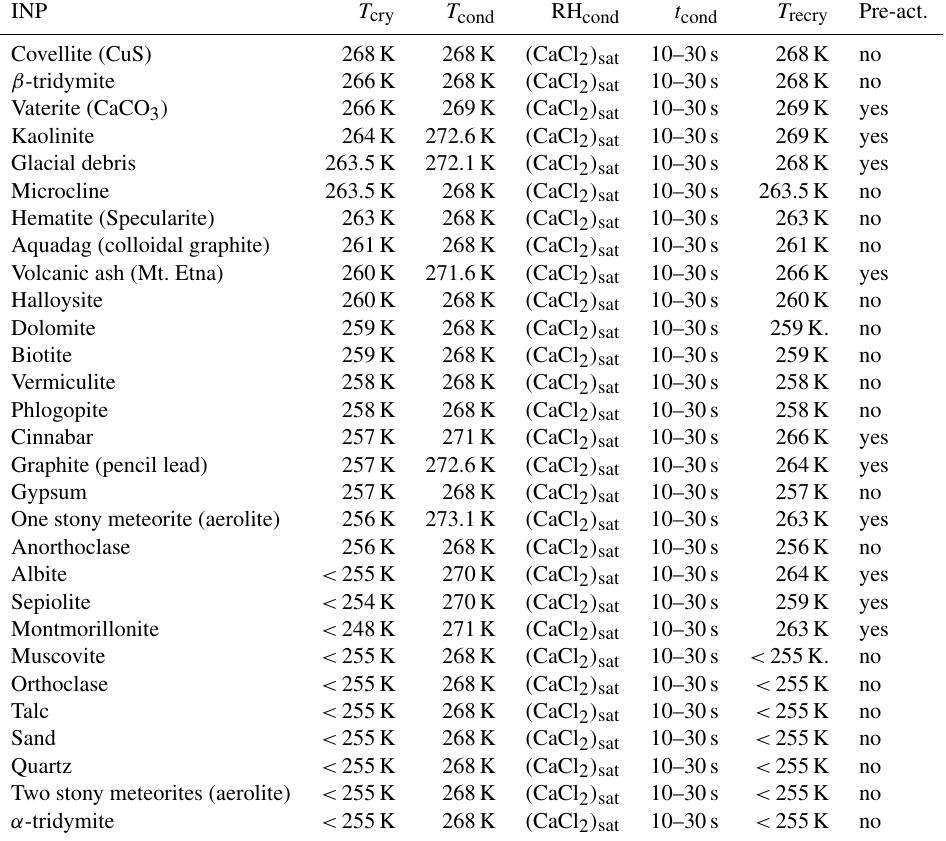
Table 4. Cloud chamber experiments by Mason and Maybank (1958). T cry – threshold temperature of first crystallization with crystallized fraction F cry ∼= 10 − 5 at S w ; T cond – conditioning temperature; RH cond – conditioning RH controlled by a saturated CaCl 2 solution, ca.